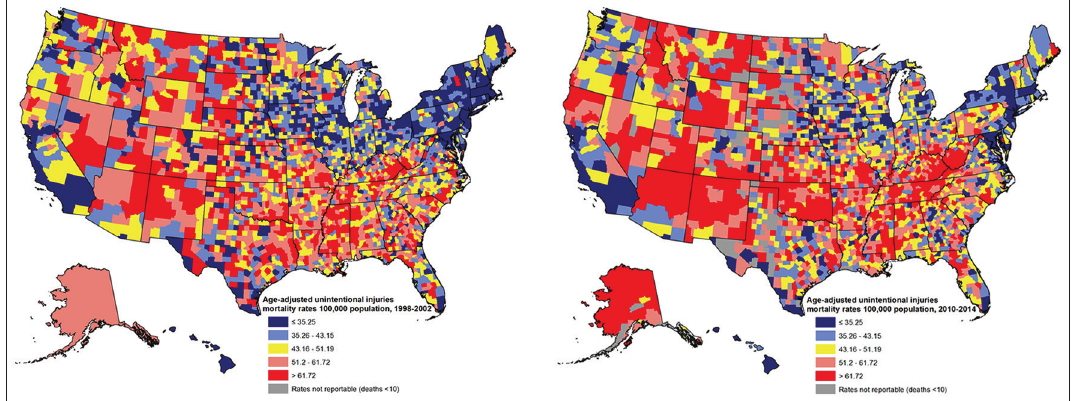
Fig ure 19. Age-Adjusted Unintentional Injury Mortality Rates per 100,000 Population for the United States (3,143 Counties), 1998-2002 and 2010-2014 Source: Derived from the 1998-2014 National Vital Statistics